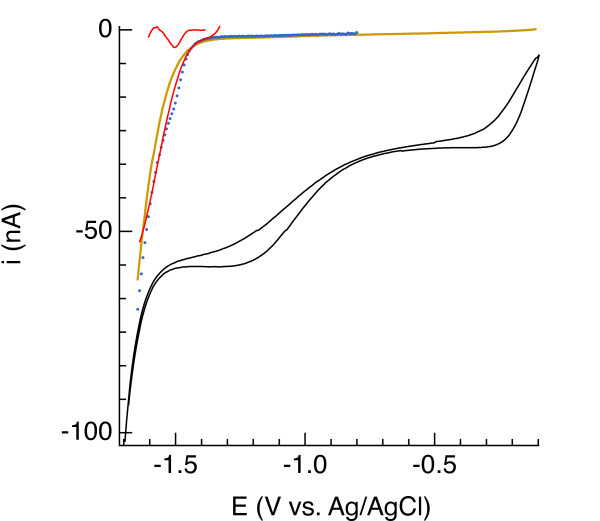
 The black line is a cyclic voltammogram showing current (i, in nanoamperes) versus potential (E, in volts) during reduction of O2to H2O2and H2O2to H2O in artificial seawater equilibrated with air at 20°C. The brown line is a linear sweep voltammogram (LSV) of deaerated seawater. The dotted blue line is an LSV of deaerated seawater containing 110 μM Mn(II), fit by a 4th-order polynomial to yield a peak representing the faradaic Mn(II) current shown in red.